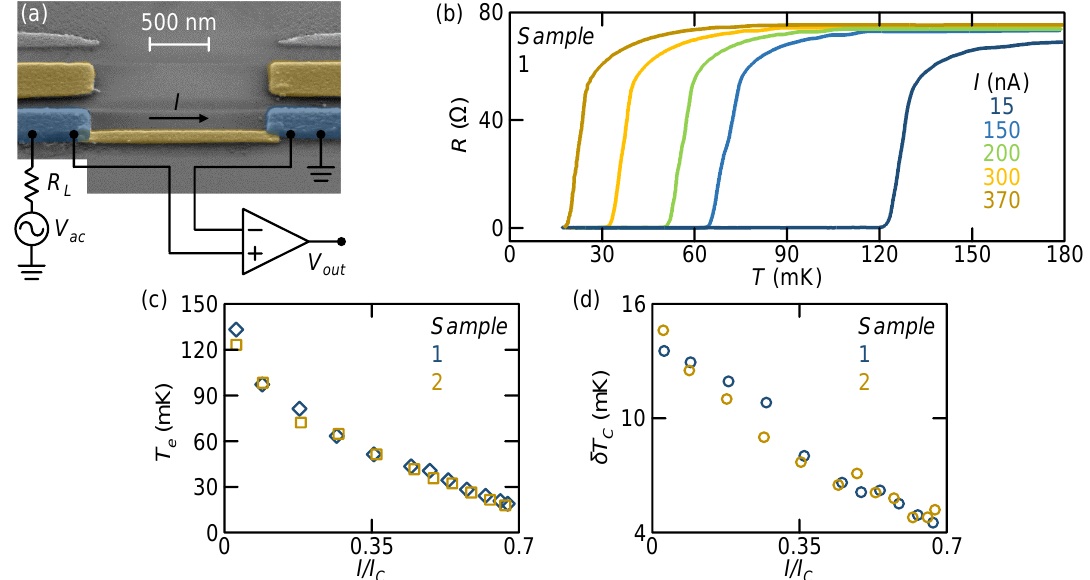
Figure 5. Current control of the resistance versus temperature characteristics in a 1DJ. ( a ) False-colored scanning electron micrograph of a 1DJ. The nanowire is made of an Al/Cu bilayer (yellow) separating two thick Al electrodes (blue). The 1DJ is AC current-biased (amplitude I ), while the voltage drop across the wire ( V out ) is measured through a lock-in amplifier. The load resistor ( R L (cid:29) R N ) guarantees constant bias current while transitioning to the normal-state. ( b ) Selected normalized resistance ( R ) versus temperature ( T ) characteristics recorded for different values of bias current ( I ). ( c ) Dependence of the escape temperature ( T e ) on bias current normalized with respect to the zero-temperature 1DJ critical current ( I / I C ) for two different samples. ( d ) Width of the phase transition ( δ T C ) versus I for two different